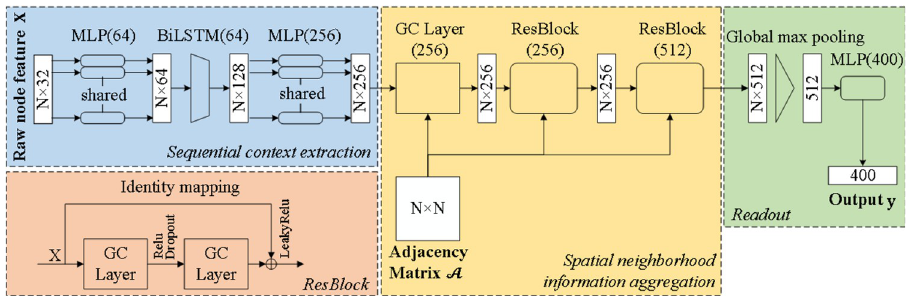
Fig 2. Architecture of GNN-based encoder. The BiLSTM module extracts low-level node features from the primary structures of proteins. The graph convolution module extracts high-level node features based on the adjacency matrices A . The readout module transforms node features to the descriptors by a global max pooling layer. The residual blocks (ResBlock) used in the graph convolutional module consists of two graph convolutional (GC) layers.